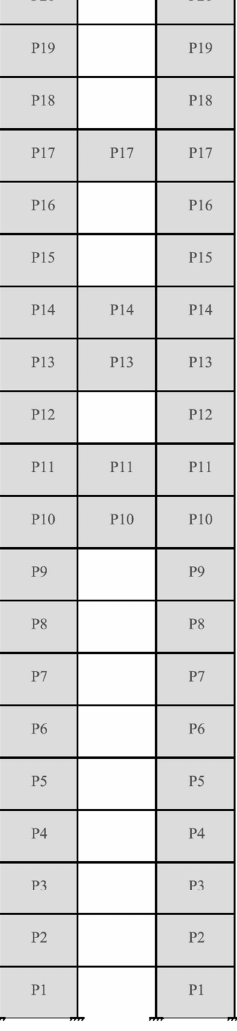
Figure 14. Best configuration of SPSW of SPSW3-20.